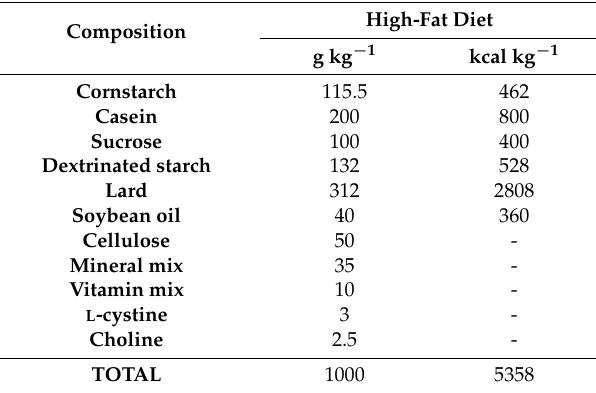
Table 1. High-fat diet composition.